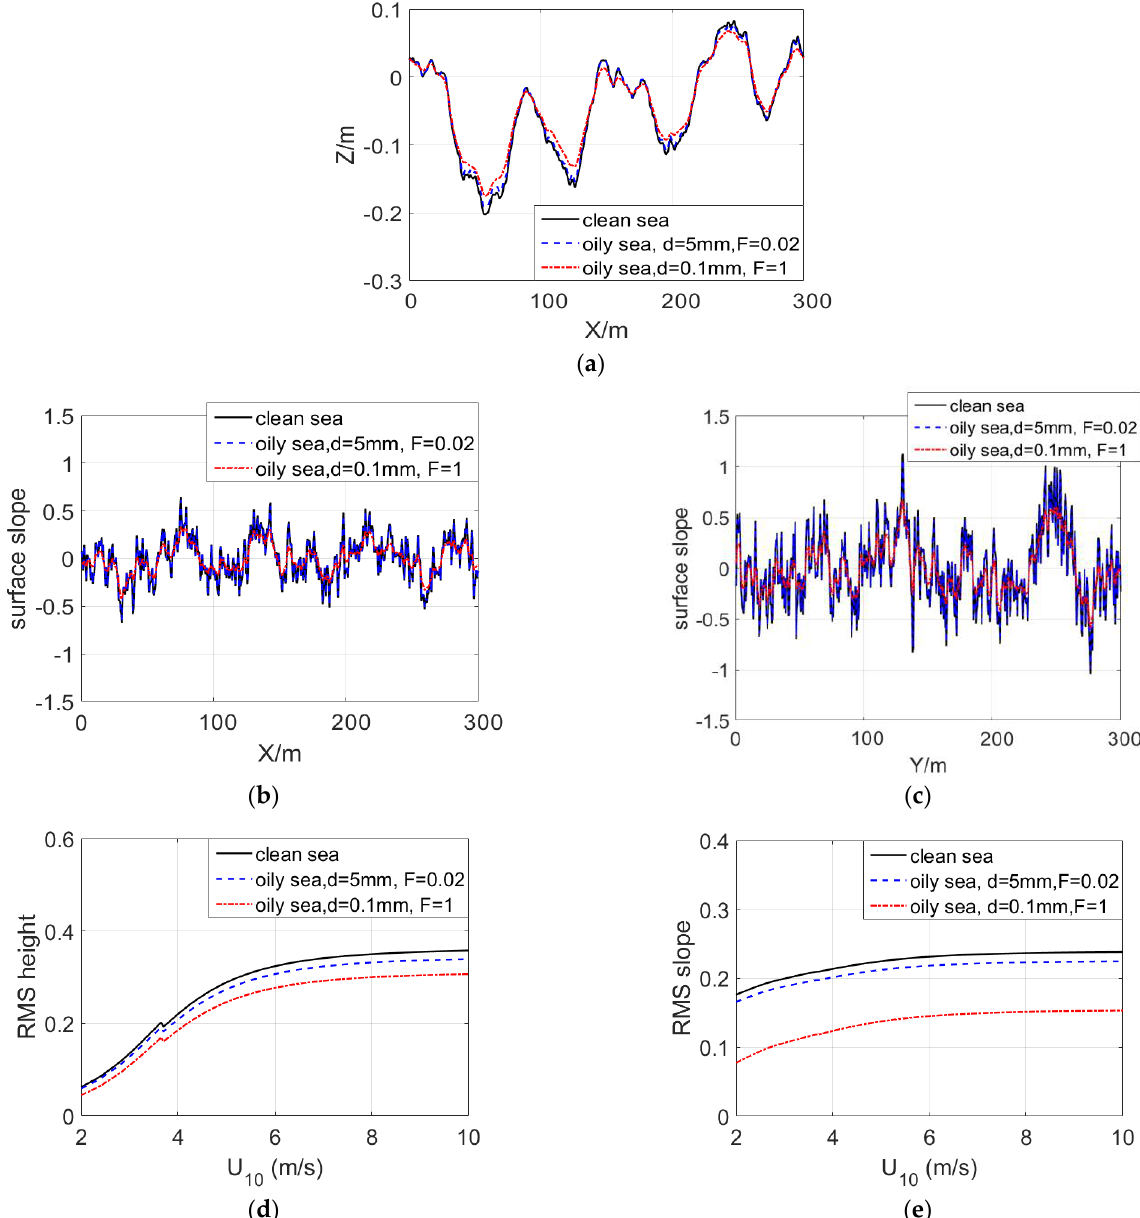
Figure 3. The geometric characteristics of oil spill − covered sea. ( a ) Features of sea surface profile along the x direction; ( b ) Slope of sea surface profile along the x direction; ( c ) Slope of sea surface profile along the y direction; ( d ) The RMS height of sea surface; ( e ) The RMS slope of sea surface.